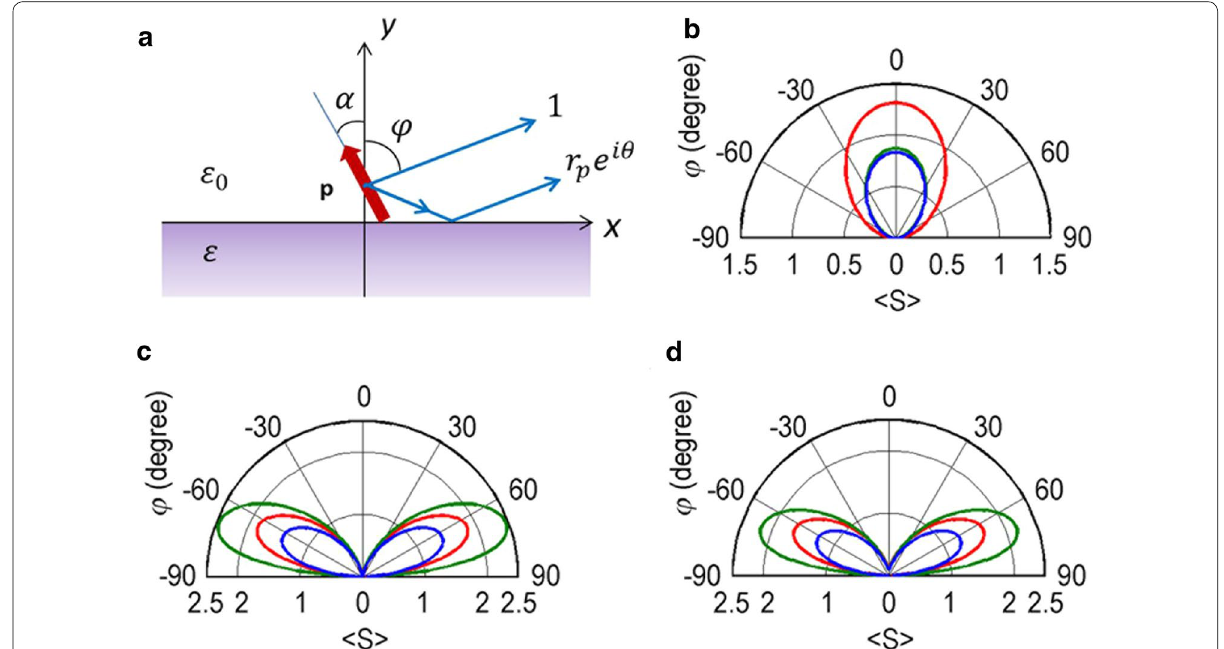
Fig. 1 Dipole radiation patterns. a A tilted dipole placed on metal surface. The tilt angle α refers to the substrate normal. b Horizontal dipole (α 90°). c Vertical dipole (α 0°). d Titled dipole (α 15°). Three different metals are assumed for substrate: Ag (red), Al (green) and Cr (blue). The = = = radiation patterns calculated at 633 nm